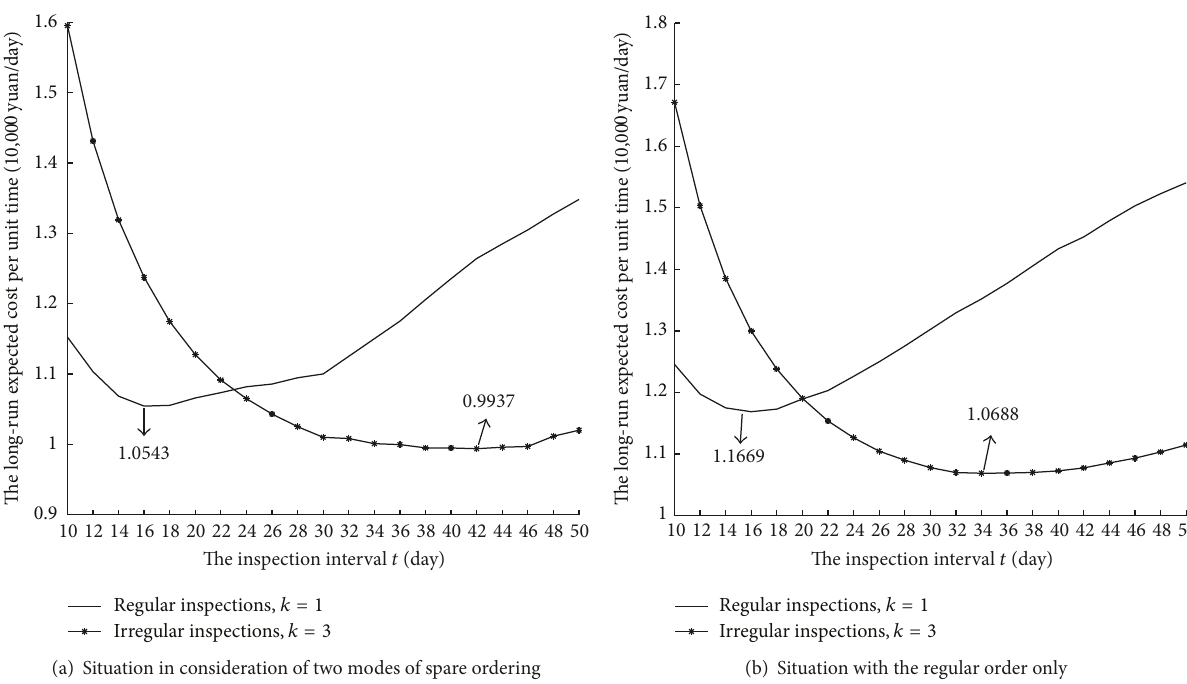
Figure 17: Results from regular and irregular